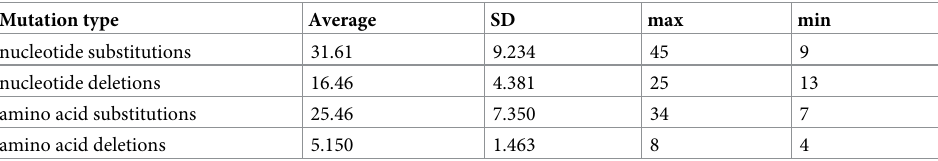
Table 1. The average number of nucleotide and amino acid substitutions, and deletions per the SARS-CoV-2 genome among 39 samples identified in Uzbekistan (with respect to the reference genome NC_045512.2). Mutation